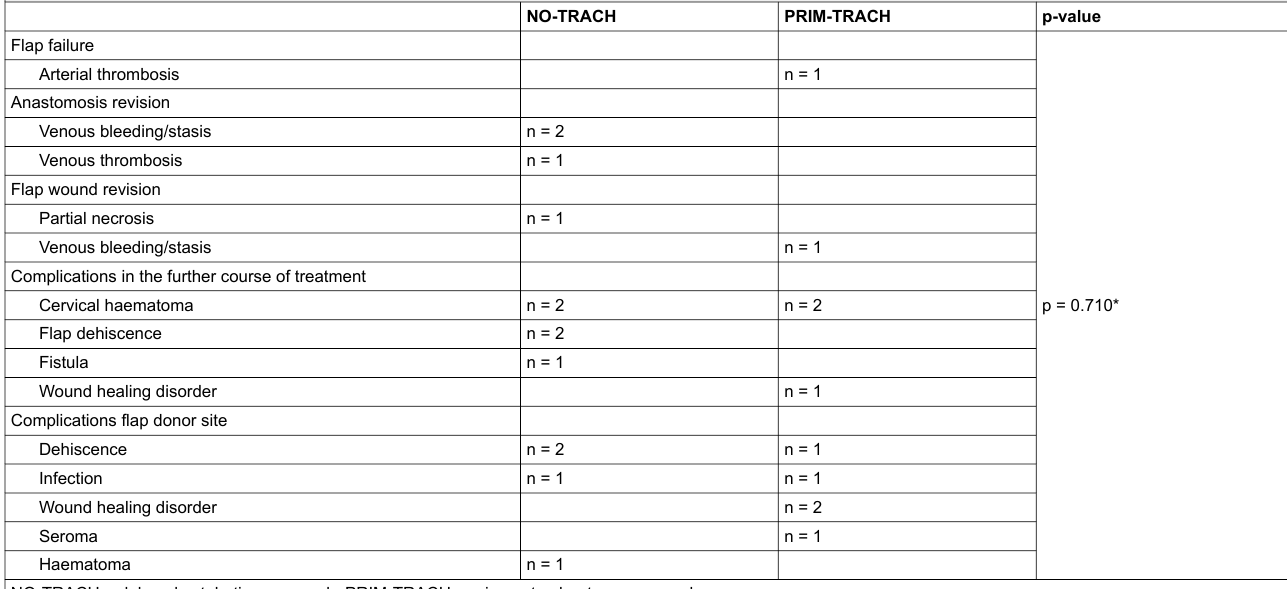
Table 3: Flap-associated complications for the NO-TRACH and the PRIM-TRACH groups.